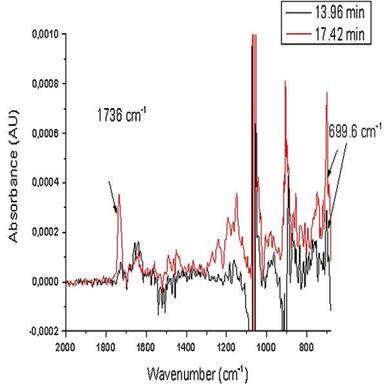
FTIR spectra of SM2, extracted at elution times of 13.96 min and 17.42 min (peak max).